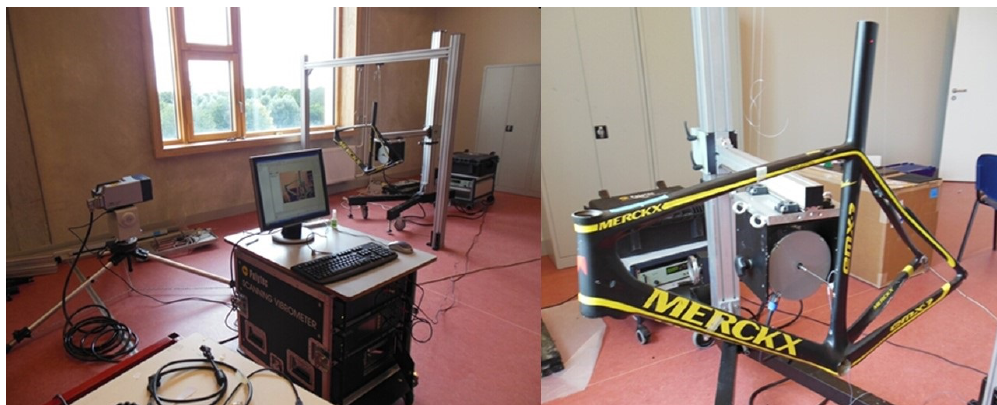
Figure 2. Photograph of the modal analysis measurement setup.